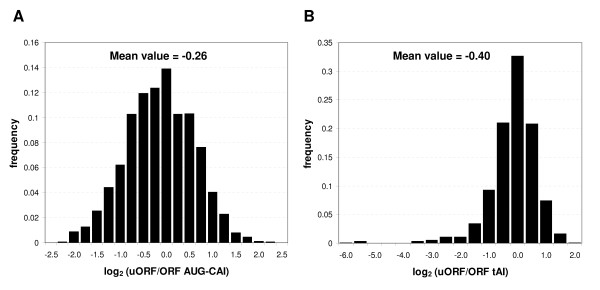
Relative uORF compositional adaption to the translational machinery. Panel A shows the frequency histogram of log2 ratios of uORF to principal ORF start codon adaption scores (AUG-CAI(r)). If a uORF is better adapted than the principal ORF, it will produce a positive log value. Panel B shows that same comparison considering the translation adpation index (tAI) of the complete reading frame in order to calculate the log2 ratio. In both cases, uORFs are considerably less well adapted in general with log2 mean values less than zero.